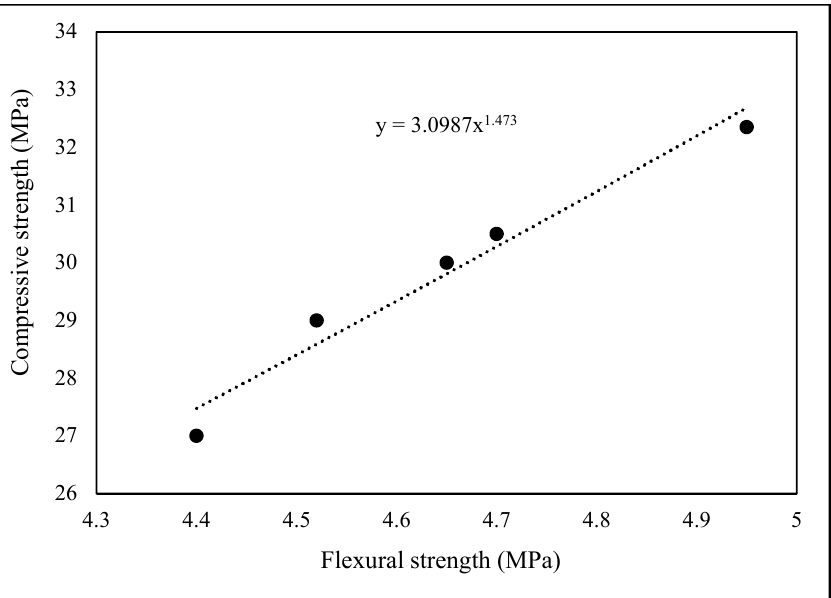
Figure 3. A meaningful correlation between flexural strength and compressive strength, and an equation for estimation of 28th-day compressive strength from flexural strength.